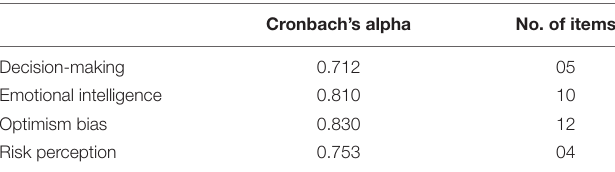
TABLE 2 | Reliability